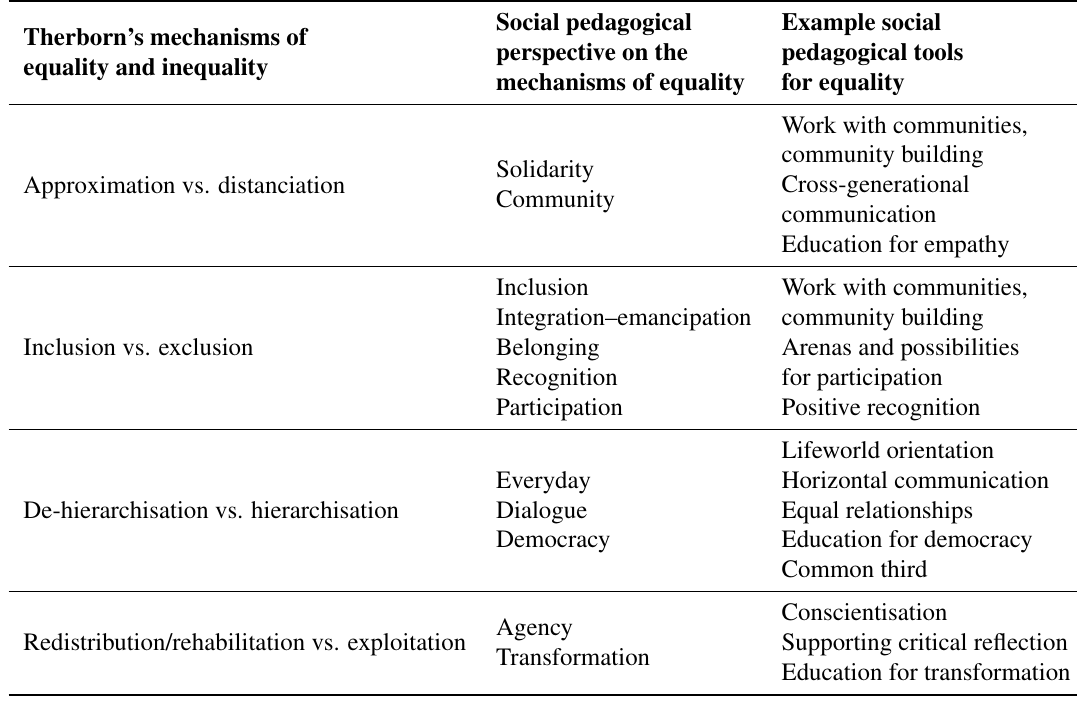
Social pedagogical perspectives on the mechanisms of equality. Therborn’s mechanisms